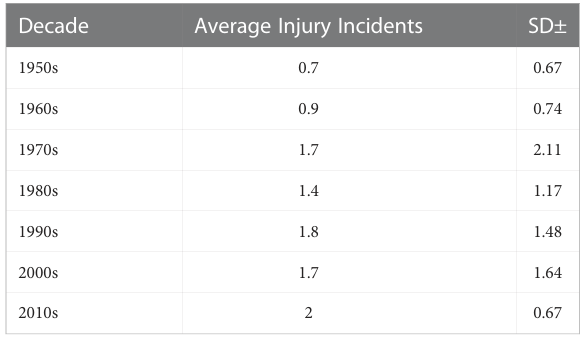
TABLE 1 Average annual number of California shark incidents resulting in injuries by decade,